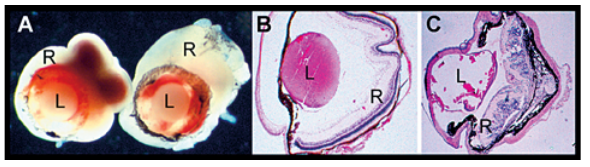
Figure 7. Eye Defects in F5/ (cid:1) Mice (A) Eyes from a P4 F5/ (cid:1) mouse demonstrating severe hemorrhaging. (B and C) H/E-stained sagittal sections through eyes of wild-type and F5/ (cid:1) 3-mo-old mice, respectively. The absence of the lens of the F5/ (cid:1) eye is a histological defect and not a phenotype of the F5/ (cid:1) eye. L, lens; R, retina. DOI: 10.1371/journal.pbio.0000052.g007 PLoS Biology |